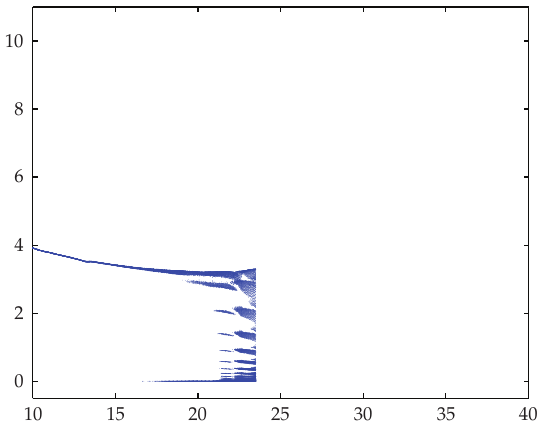
Figure 3: Bifurcation diagram of system (cid:2) 1.1 (cid:3) : successive maxima of the infected are plotted for increasing values of the time delay τ , with parameters r (cid:8) 0 . 1, K (cid:8) 80, β (cid:8) 0 . 1, μ 1 (cid:8) 0 . 5, μ 2 (cid:8) 0 . 1, α (cid:8) 0 . 05 , and γ (cid:8) 0 . 5.